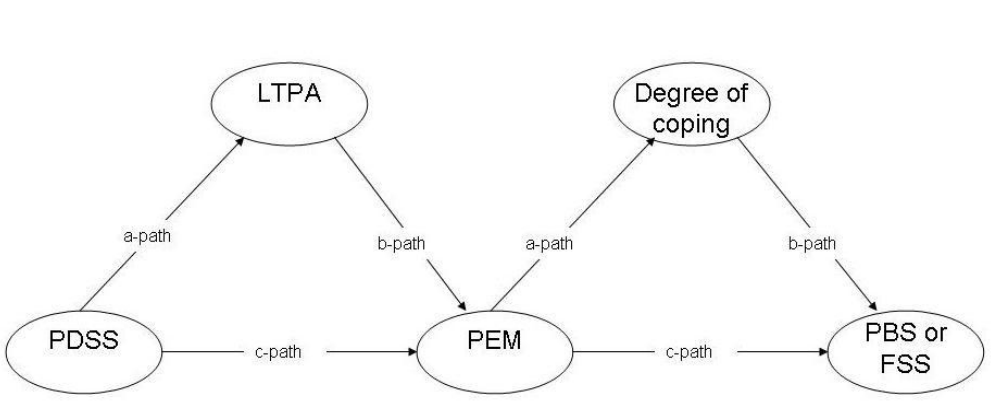
Conceptual models used for the mediation